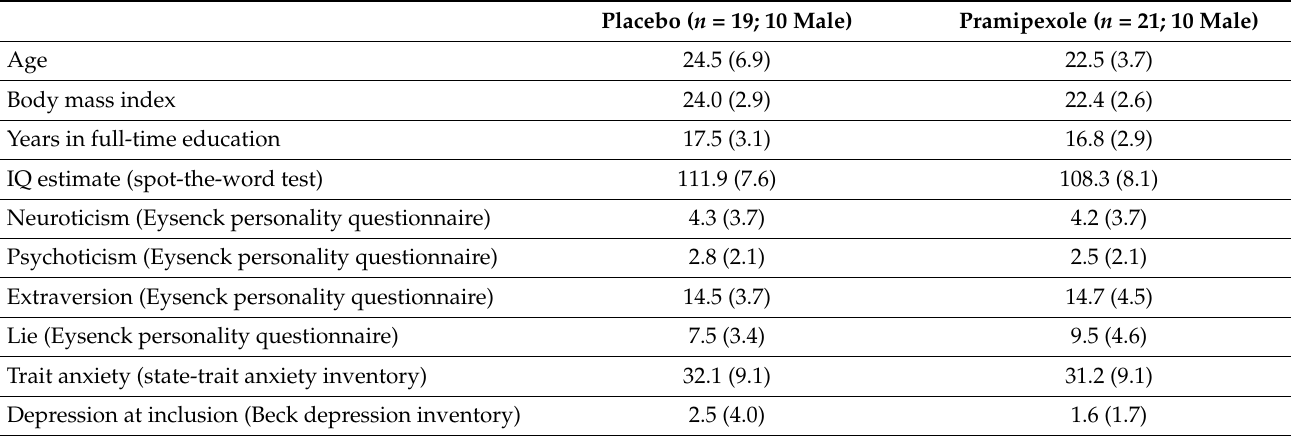
Table 1. Basic demographic, physical, and psychological characteristics of 40 healthy volunteers randomly allocated to subacute treatment with either placebo or pramipexole (means with standard deviations in parentheses). Placebo ( n = 19; 10